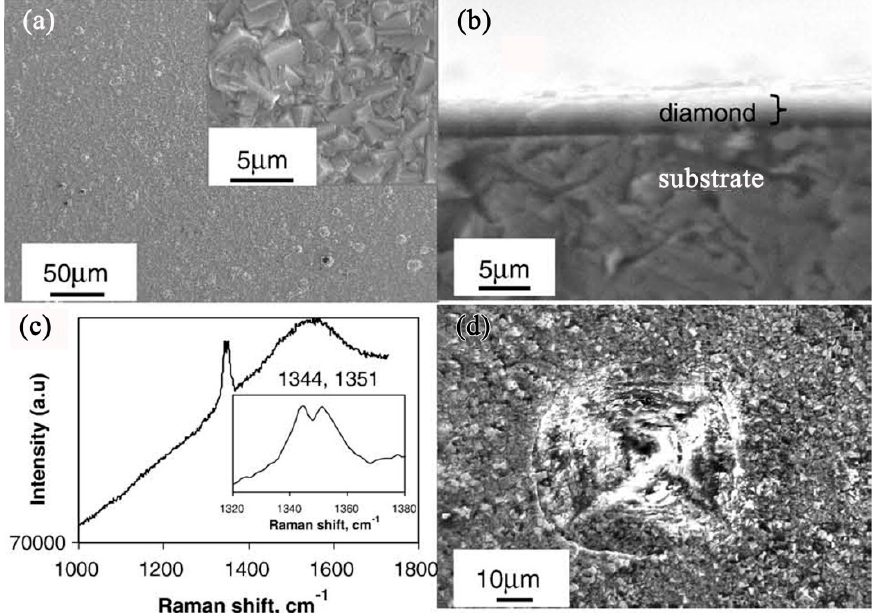
Figure 5. SEM images of diamond film deposited for 12 h on Fe-Cr-Al substrate: ( a ) general and magnified (inset) views of the diamond film; ( b ) a cross sectional view; ( c ) Raman spectrum showing the exact peak position (inset); ( d ) a top view of the film after indentation test at a load of 9.8 N. (Reproduced with permission from [48]).